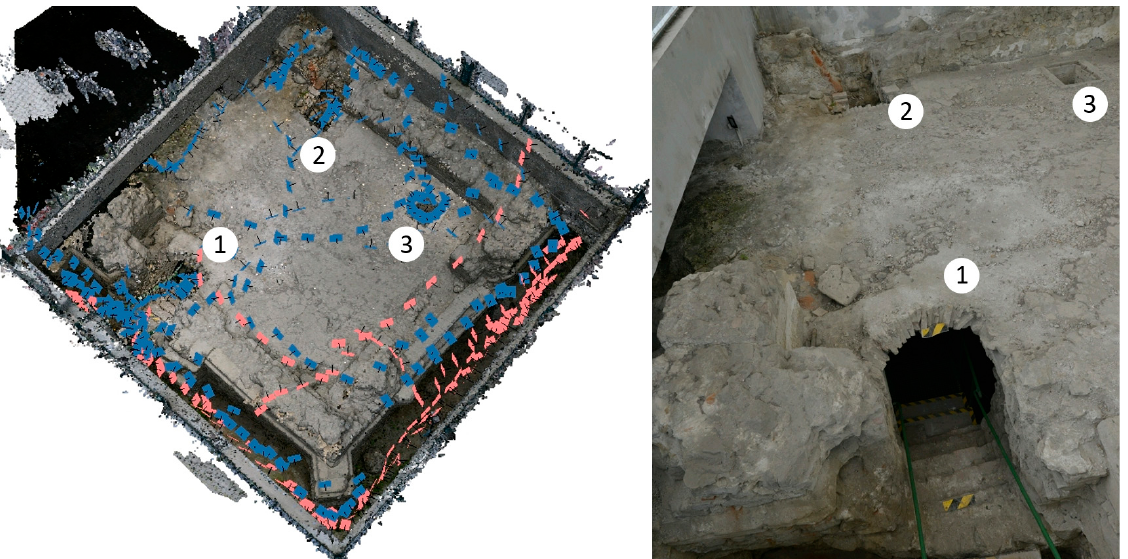
Figure 4. Positions of cameras in relation to the object (images with fisheye lens highlighted in red) ( left ), and the position of the connecting openings between the exterior and the ossuary ( right ).